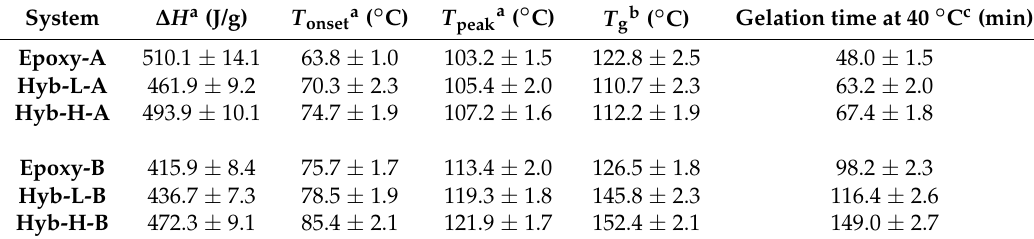
Table 2. DSC results for the neat epoxy resin and the hybrid epoxy-silica resin at different DES contents and curing agent